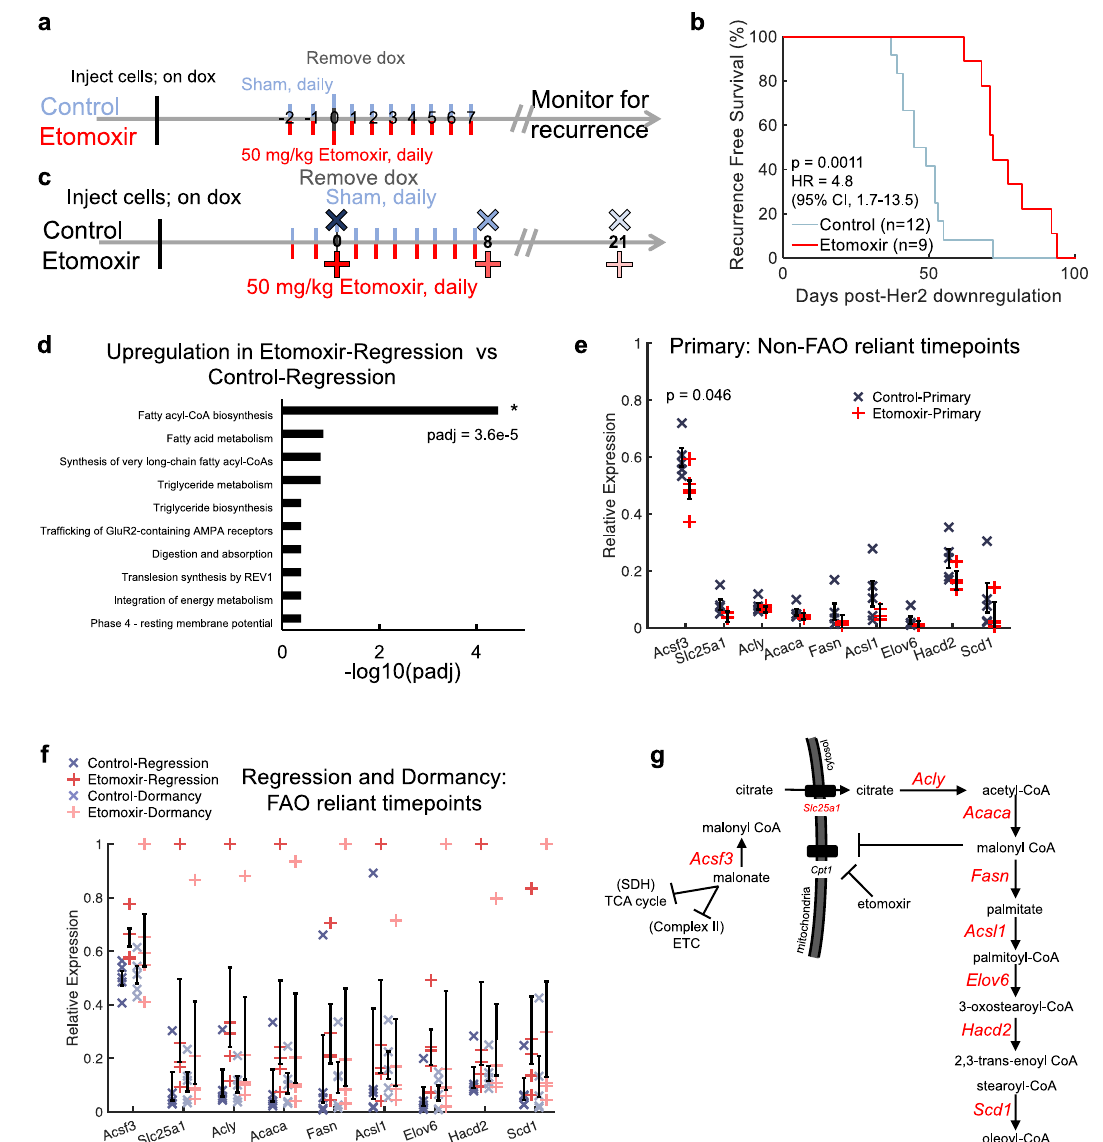
Fig. 5 Inhibiting fatty acid oxidation in regressing tumors impairs recurrence and increases lipid synthesis. a Schematic of recurrence assay comparing control and Etomoxir-treated mice. b Kaplan – Meier plot showing recurrence-free survival (RFS) between untreated tumors (Control) and tumors treated with Etomoxir. Statistical comparison was determined by a Log-rank Test. (Control mice, n = 12; Etomoxir-treated mice, n = 9). c Schematic showing time points of tumor harvest for RNA sequencing. d Gene set over-representation enrichment analysis comparing Etomoxir and control regressing tumors. Statistical comparisons of enriched pathways were performed using the Wald test followed by the Benjamini and Hochberg ’ s correction for multiple comparisons. e RNA sequencing analysis of fatty acyl-CoA biosynthesis- related gene set in primary tumors (non-fatty acid oxidation (non-FAO)-reliant time points). ( n = 5 tumors per group). f RNA sequencing analysis of fatty acyl-CoA biosynthesis-related gene set in regressing and dormant tumors (FAO-reliant time points). ( n = 5 tumors per group). Error bar = standard error of the mean. Statistical comparisons of expression levels were performed with an ANOVA followed by a Tukey test for multiple comparisons. g Schematic showing transcriptional regulation of fatty acid synthesis and elongation where genes quanti fi ed in ( e ) and ( f ) are shown in red. SDH succinate dehydrogenase, ETC electron transport regression time point is where 2-NBDG 60 was signi fi cantly higher As a fi rst step towards understanding how fatty acid oxidation inhibition extended tumor-free survival, RNA sequencing of following treatment. To examine if this observation was speci fi c to primary, regressing, and dormant (mid-way through expected tumors reliant on fatty acid oxidation (oncogene ablated tumors), recurrence in control) tumors treated with (red) and without (blue) mRNA expression levels of each gene (7 total) within this gene set Etomoxir was performed (Fig. 5c). When speci fi cally comparing plus two additional key genes within the fatty acid synthesis the over-representation of gene sets between the Etomoxir and pathway ( Fasn, Acsl1 ) was compared. The primary time points control regression time points, the only signi fi cantly enriched (reported to rely on glucose metabolism) show little differences in gene set in the Etomoxir-treated tumors ( n = 5 per group) was gene expression between the treated and control tumors (Fig. 5e; genes related to fatty acyl-CoA biosynthesis ( p adj < 0.05; Wald test with Benjamini and Hochberg correction) (Fig. 5d). This same